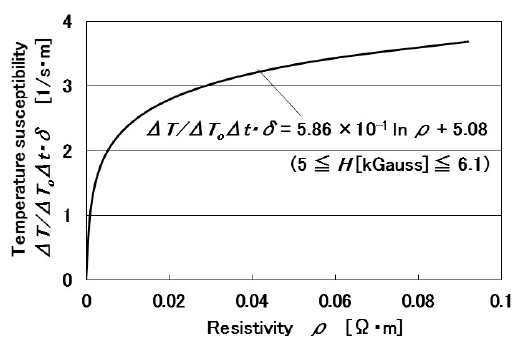
Figure A1. Relation between temperature susceptibility and resistivity. Δ T is the change in temperature of dry-type MCF rubber by touching to a heated body, Δ t the response time of temperature at heating, Δ T o the enhancement of temperature applied by heating, δ the thickness of MCF rubber.